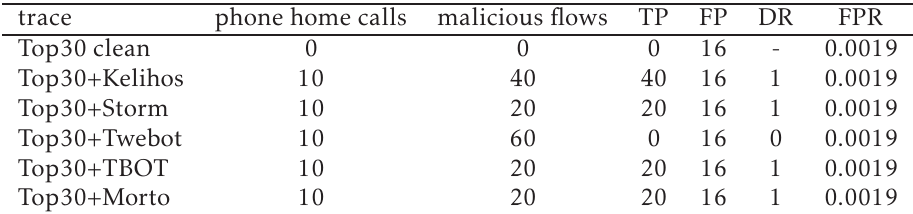
Table 2. Measured FPR and DR of UDI detection with 1 clean and 5 infected